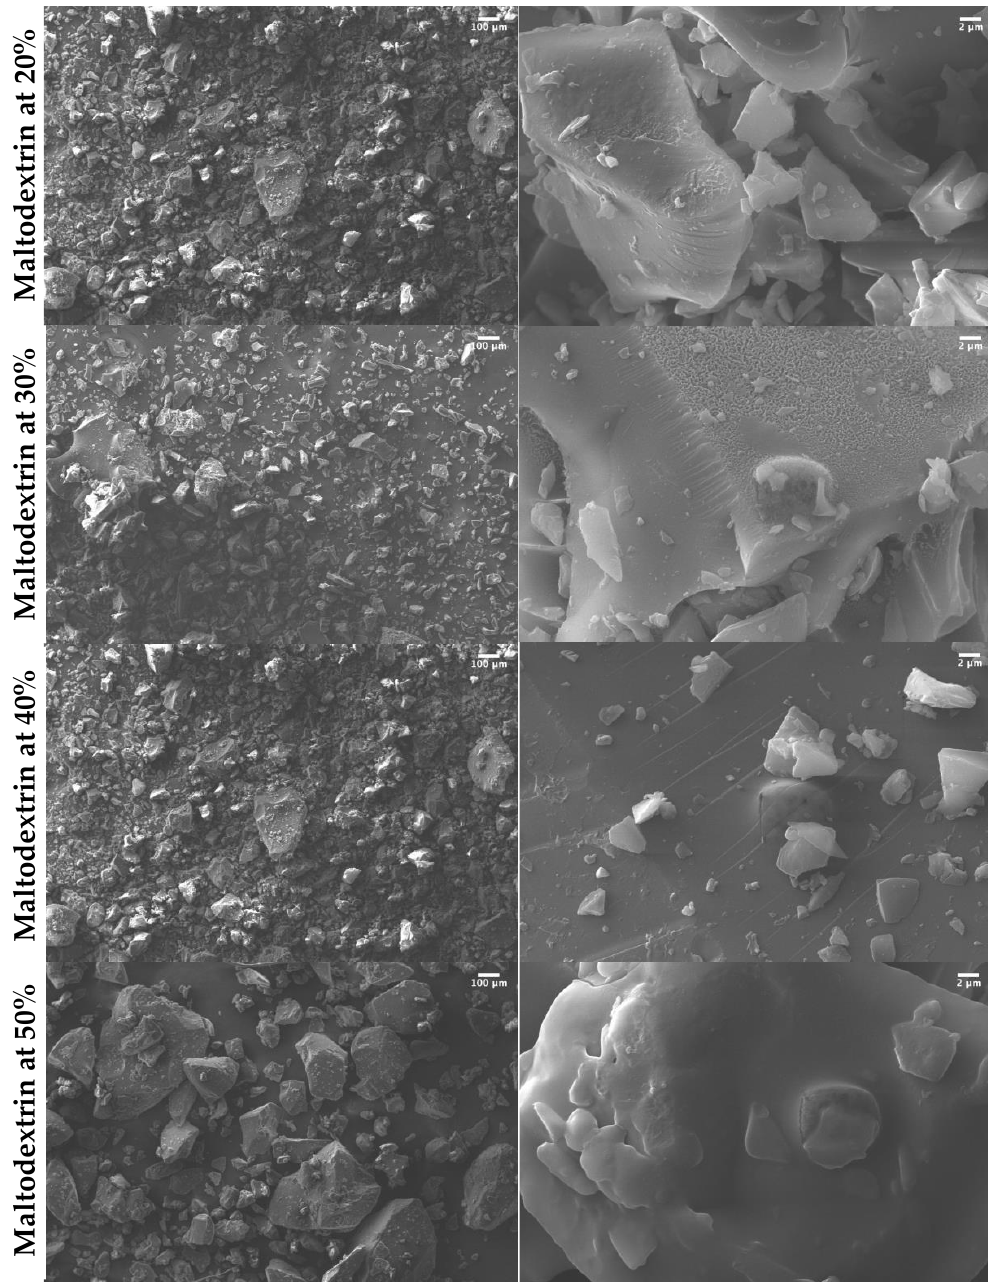
Figure 2. Scanning electron microscopy (SEM) images of freeze-dried powders obtained using different wall materials and mixtures.